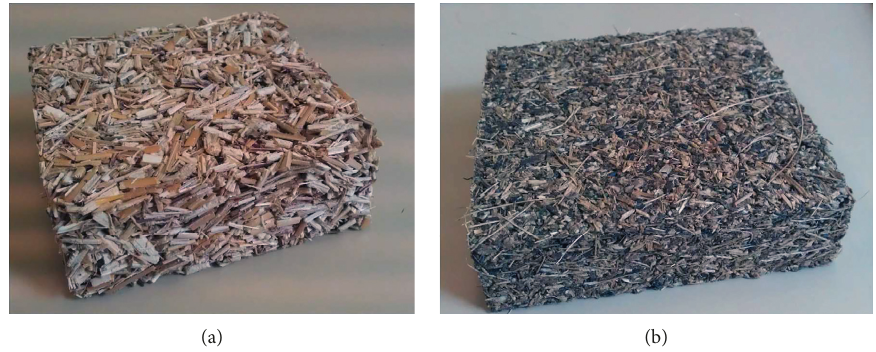
Figure 1: Composite materials. (a) Miscanthus fiber panel. (b) Sunflower stalk fiber panel.